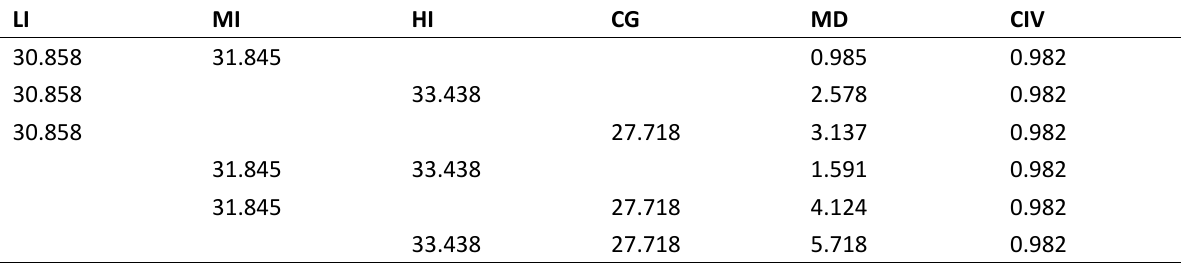
Table 7. Scheffe’s Test showing the differences between paired means of different groups on muscular endurance LI MI HI CG MD